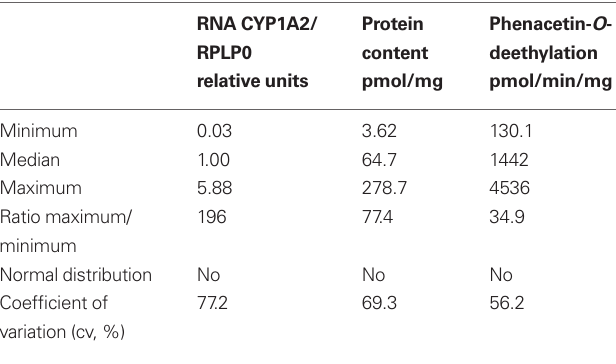
Table 2 | Population variability of hepatic CYP1A2 expression phenotypes ( n =